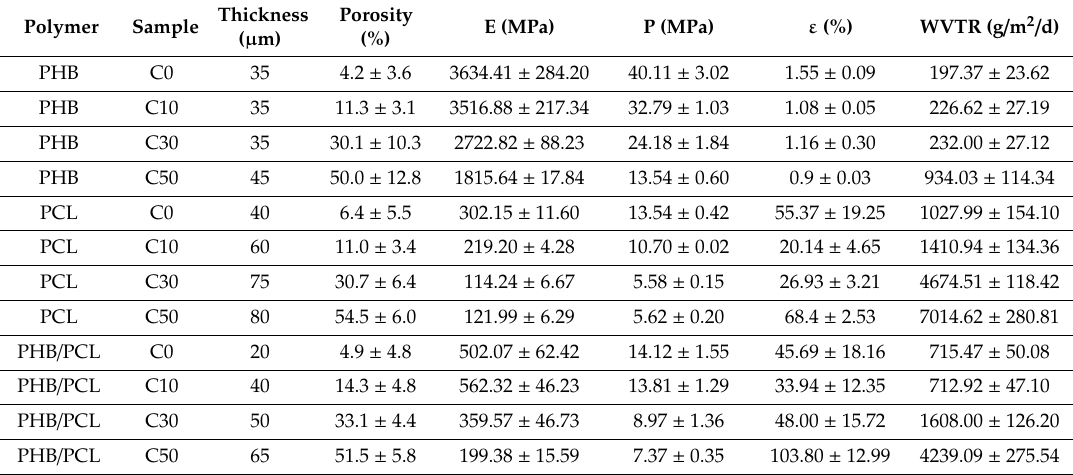
Table 2. Physical / mechanical properties and water vapor transmission rate of polymer